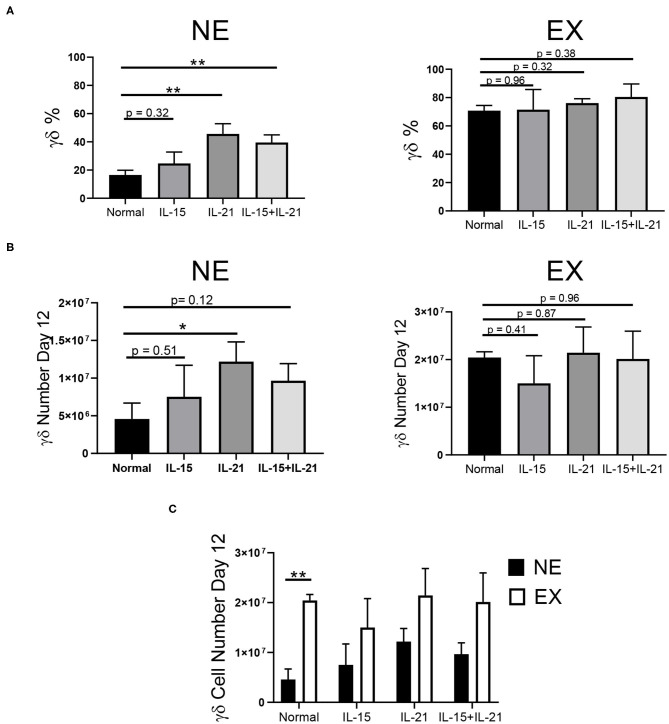
Effects of IL-15, IL-21, and IL-15+IL-21 on expansion across three independent experiments. (A) The addition of IL-21 (Student's t-test, p = 0.0027) and IL-15+IL-21 (Student's t-test, p = 0.0035) increased γδ T cell percentage by day 12 of NE (n = 7) in comparison to normal expansion conditions. Adding IL-15, IL-21, and IL-15+IL-21 had no effect on the percentage of γδ T cells in culture on day 12 for EX (n = 3) (Student's t-test, p > 0.05). (B) The number of γδ T cells in culture on day 12 for NE was increased with the addition of IL-21 (Student's t-test, p = 0.0427), but not for IL-15 or IL-15+IL-21 (multiple Student's t-tests, p > 0.05). There was no difference in the number of γδ T cells in culture on day 12 for EX under normal expansion conditions or with the addition of IL-15, IL-21, or IL-15+IL-21 (multiple Student's t-tests, p > 0.05). (C) EX had a greater number of γδ T cells on day 12 under normal expansion conditions as compared to NE (Student's t-test, p = 0.002), however there was no difference in the number of γδ T cells in culture on day 12 between NE and EX with the addition of IL-15, IL-21, and IL-15+IL-21 (multiple Student's t-tests, p > 0.05). *p < 0.05; **p < 0.005.